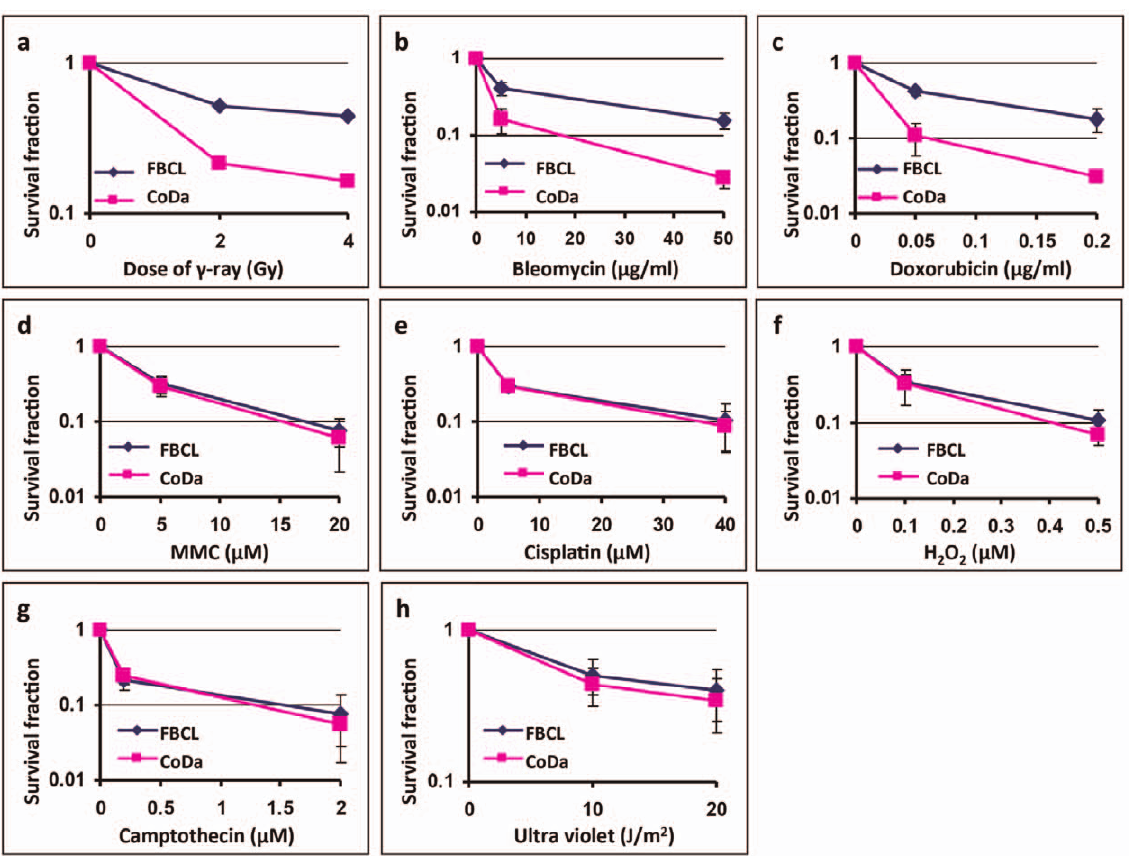
Figure 7. Cellular sensitivity of CoDa cells to various DNA damaging agents. The cellular sensitivity of CoDa cells was assessed using growth inhibition assay with continuous drug treatment (see Materials and Methods for details), including bleomycin (b), doxorubicin (c), mitomycin- C (d), cisplatin (e), hydroxyperoxide(f) and camptothecin(g). Panels a and h show the sensitivities with ionizing radiation and ultra violet treatment using the same growth inhibition assay as drug treatments. Shown are the averages form 3–5 independent experiments. Error bars are standard deviations.